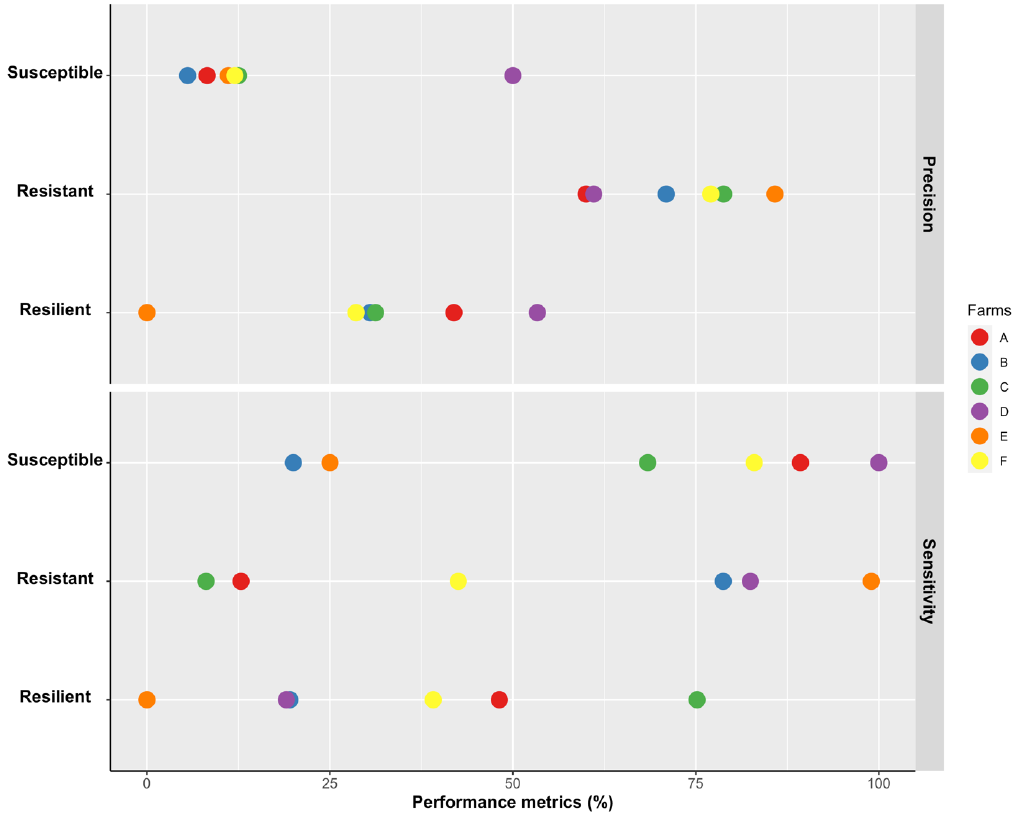
Figure 2. Precision and sensitivity of multinomial logistic regression model using sex, age class, month of record, body weight, body condition score, and Famacha© degree as explanatory variables and response classes of the parasitic infection (resistant, resilient, and susceptible) as the response variable for each farm. Performance metrics were calculated leave-one-farm-out cross-validation technique, alternating the data from one specific farm as the testing set and the remaining as training